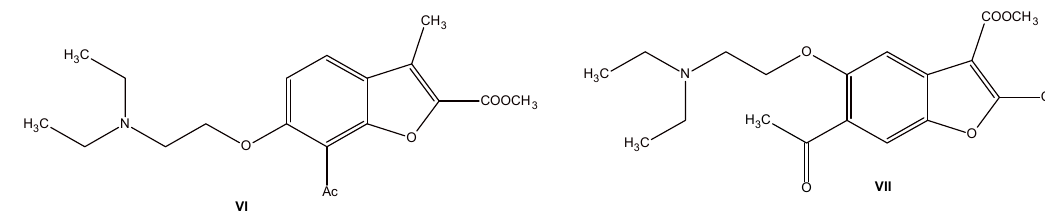
Figure 3. Structures of 2- and 3-benzofurancarboxylic acid derivatives VI–VII with cytotoxic activity.